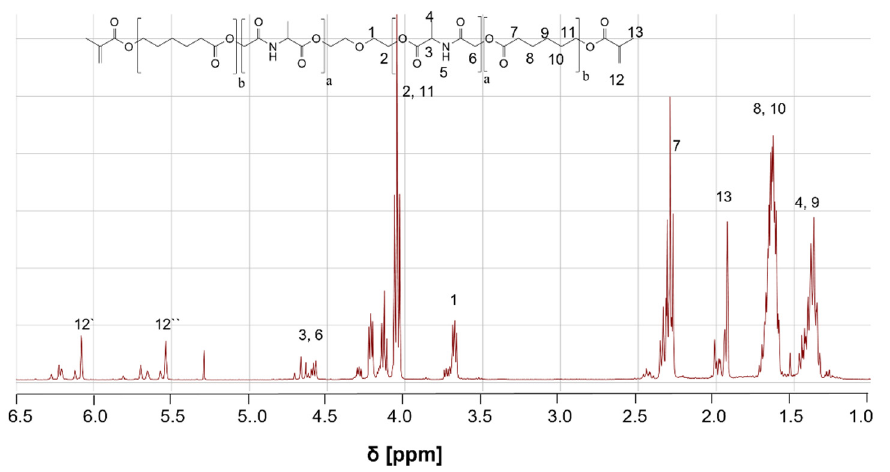
Figure 2. 1 H-NMR Spectra of Poly-(Alanine- ε -Caprolactone)dimethacrylate 2:8. Figure 3 and Table 1 summarize the 1 H-NMR spectra of ACM 8:2, ACM 6:4, ACM 4:6